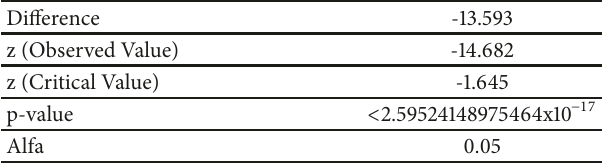
Table 13: Results of the Z-test Module